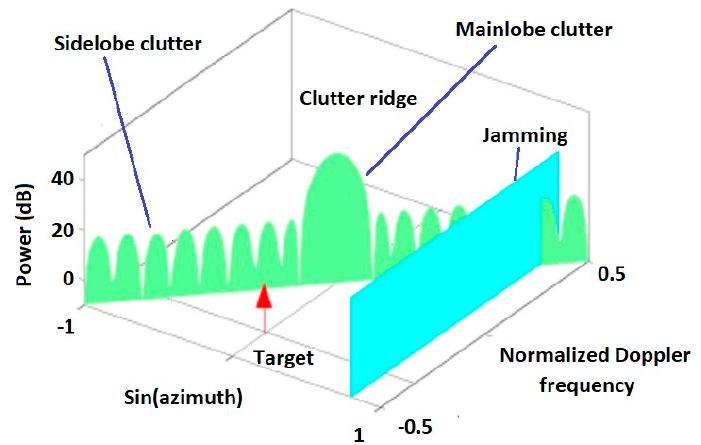
Figure 3. Clutter ridge in angular-Doppler plane.